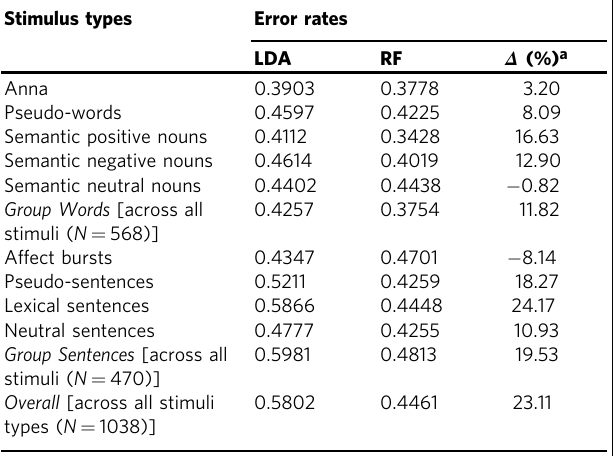
Table 2 Linear discriminant analysis (LDA) and random forest (RF) 10-fold cross-validation classi fi cation error rates for predicting vocal stimuli emotional category